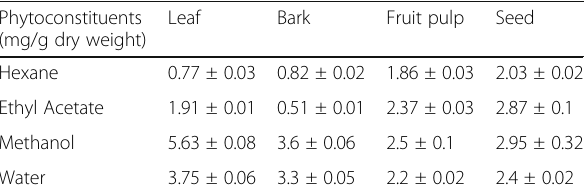
Table 2 The quantitative estimation of total flavonoid content of the different solvent extracts of S. caryophyllatum leaf, bark fruit pulp and seed Phytoconstituents Leaf Bark (mg/g dry weight)